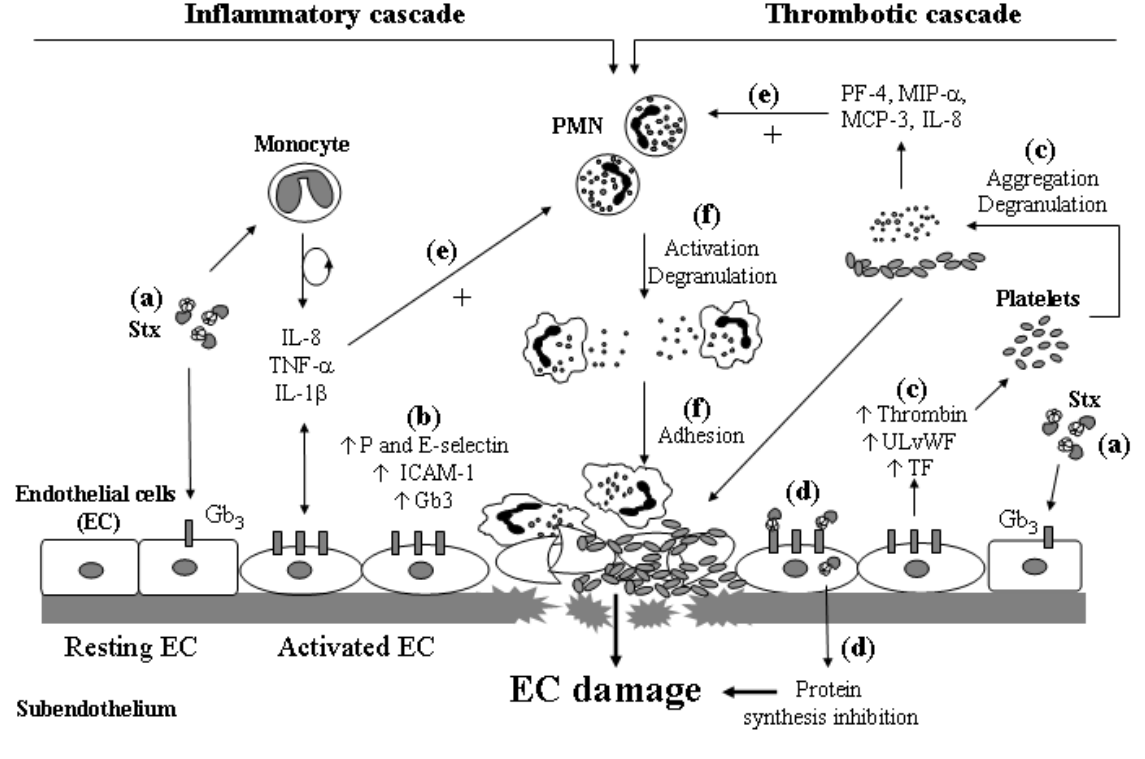
FIGURE 1. Scheme depicting the sequence of events leading to PMN activation and endothelial damage in HUS. (a) Stx binds to monocytes and endothelial cells (EC) promoting their activation and secretion of cytokines and chemokines. (b) Cytokines released cause up-regulation of adhesion molecules and of the Gb 3 receptor in EC. (c) Activation of EC leads to secretion of thrombotic factors that induce platelets aggregation and degranulation. (d) Stx internalization in activated EC induces inhibition of protein synthesis. (e) Factors released by activated endothelium, monocytes and platelets collaborate in PMN activation. (f) Activated PMN release their granule content, produce reactive oxygen species, adhere to EC and, together with platelets, potentiate Stx-induced EC damage. ULvWF: ultra large von Willebrand factor, TF: tissue factor, TNF- α : tumor necrosis factor- α , IL-1 β : interleukin-1 β , PF-4: platelet factor 4, MIP- α macrophage inflammatory protein- α , MCP-3: monocyte chemoattractant protein-3, IL-8: interleukin-8, ICAM-1: intercellular adhesion